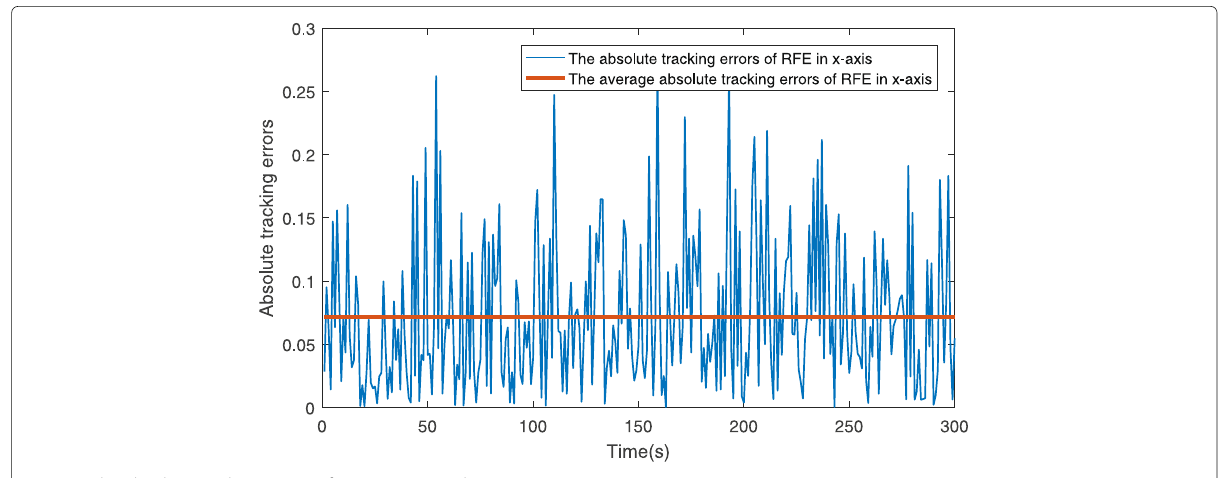
Fig. 11 The absolute tracking errors of RFE in x -axis with a i = 12